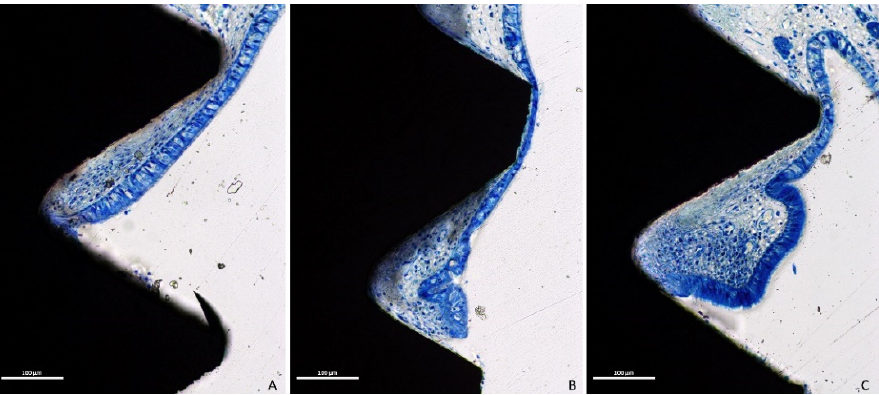
Figure 6. Photomicrographs of ground sections. The perforations were bordered by tapered epithelial cells, presenting in both groups limited ( A,B ) or high ( C ) degrees of inflammatory infiltrate. Stevenel’s blue and Alizarin red stain.